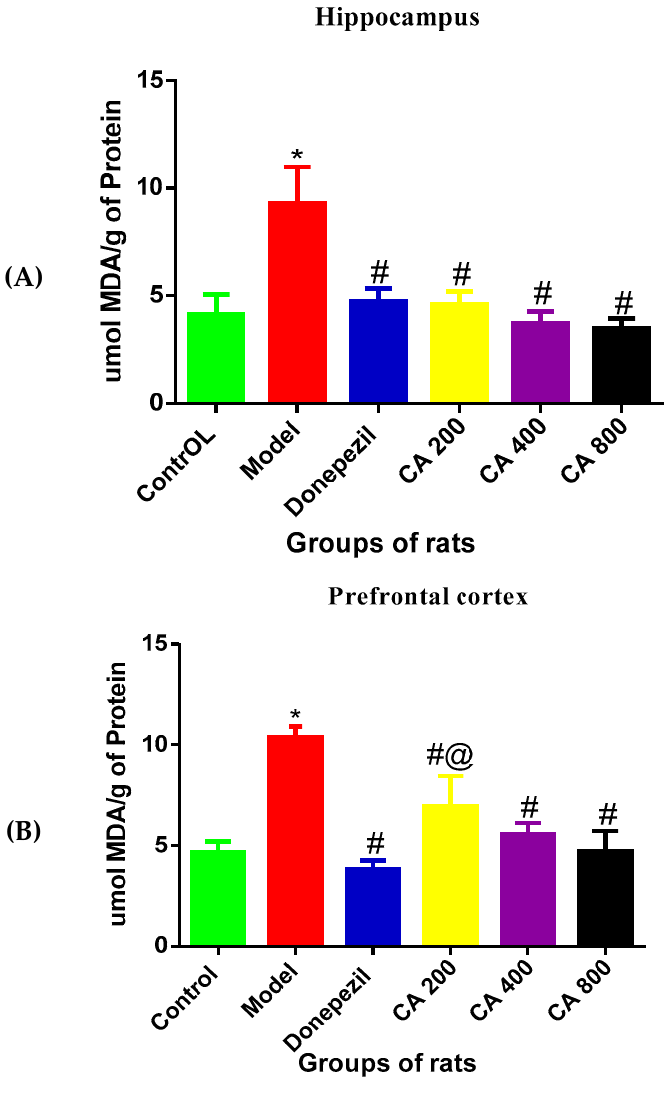
Figure 4. Effects of CA on malondialdehyde (MDA) levels in the hippocampus and cerebral cortex of D-gal- and AlCl 3 -administered rats. ( A ) Hippocampus, ( B ) cerebral cortex. Data were presented as mean ± SEM, n = 3. * p < 0.05 vs. control group, # p < 0.05 vs. model group and @ p < 0.05 vs. donepezil.